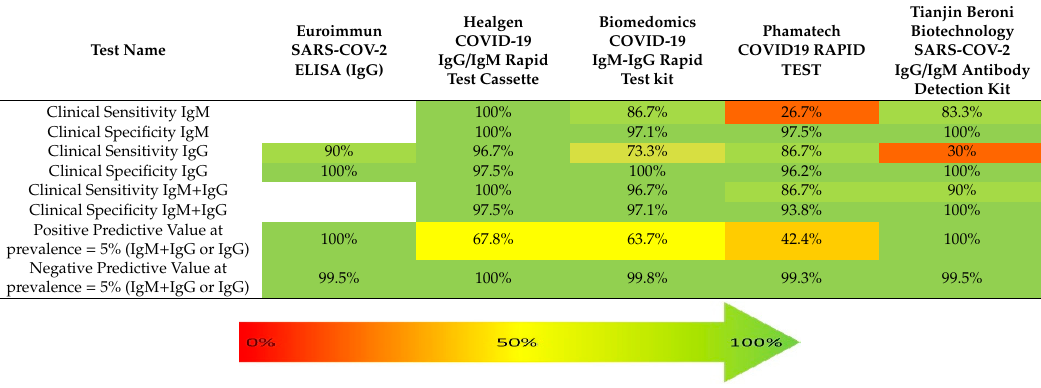
Table 6. Evaluations of Coronavirus Disease 2019 (COVID-19) serological tests, including sensitivity, specificity, and predictive value [31] (updated 13 June 2020, online sources according to manufacturers’ specification).